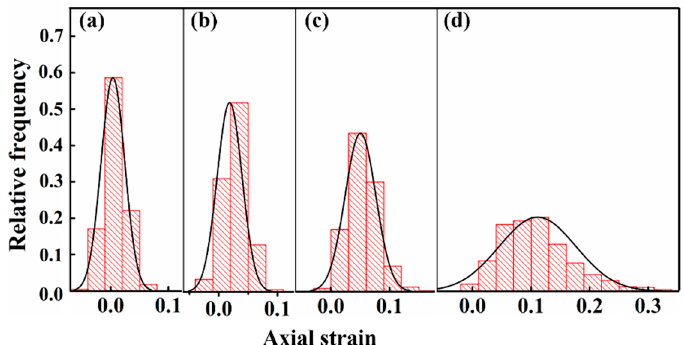
Figure 5. Variation of probability distributions of axial strain with tensile macro-strain: ( a ) 1.45%; ( b ) 2.77%; ( c ) 4.7%; ( d ) 12.75%.